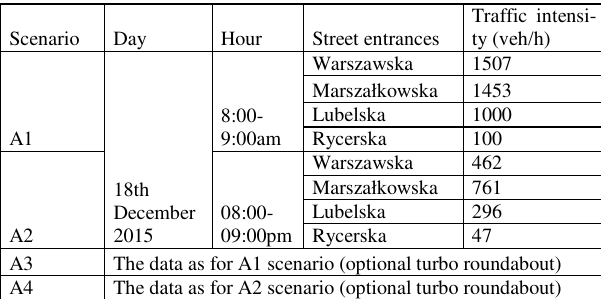
Table 1. The traffic volume for selected street entries in selected hours of the day, with the division on the analyzed scenarios Scenario